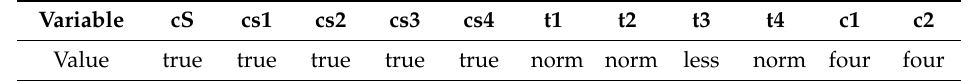
Table 3. Observations for Heat Control